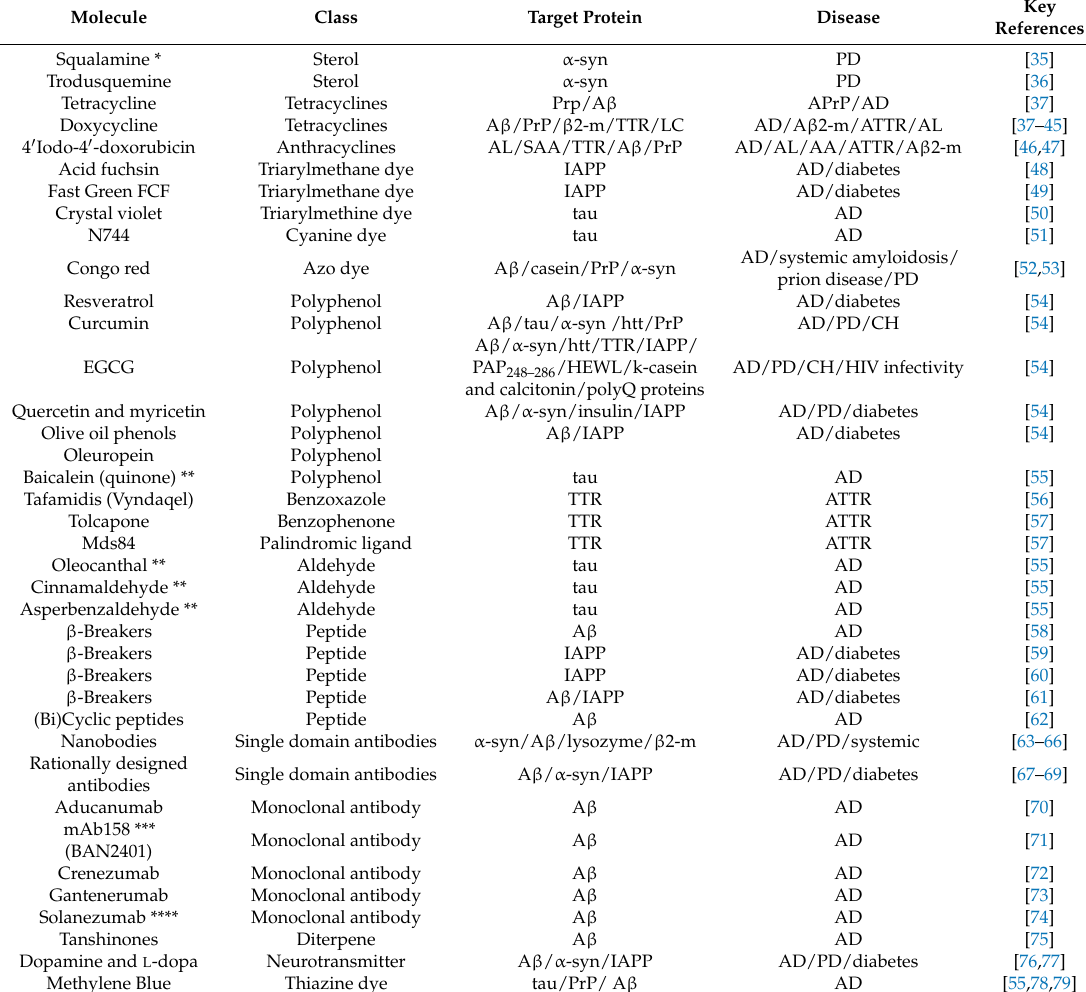
Table 1. A compilation of anti-aggregation compounds against amyloid